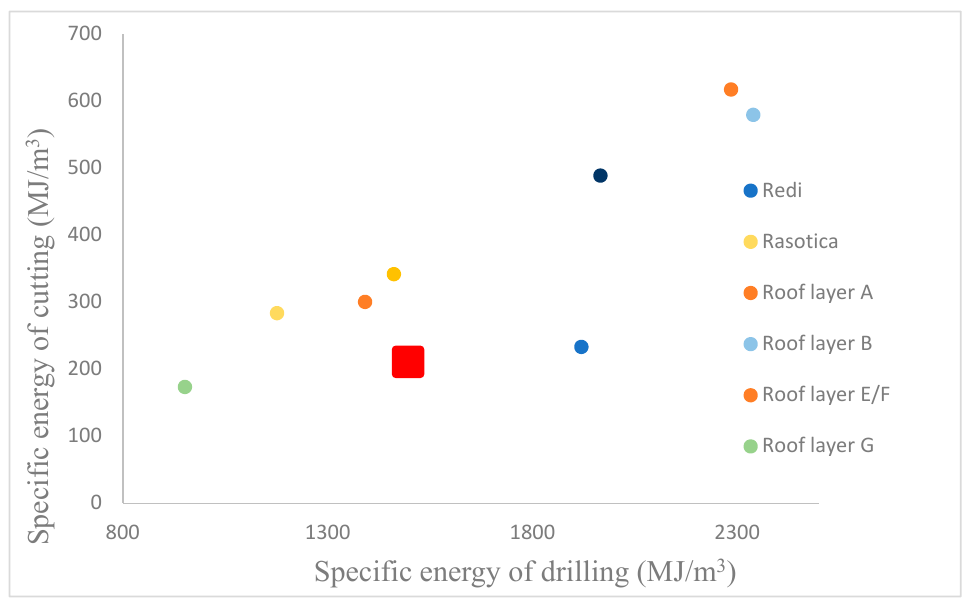
Figure 9. Presentation of the field measurement of specific energies with laboratory measurements by groups.